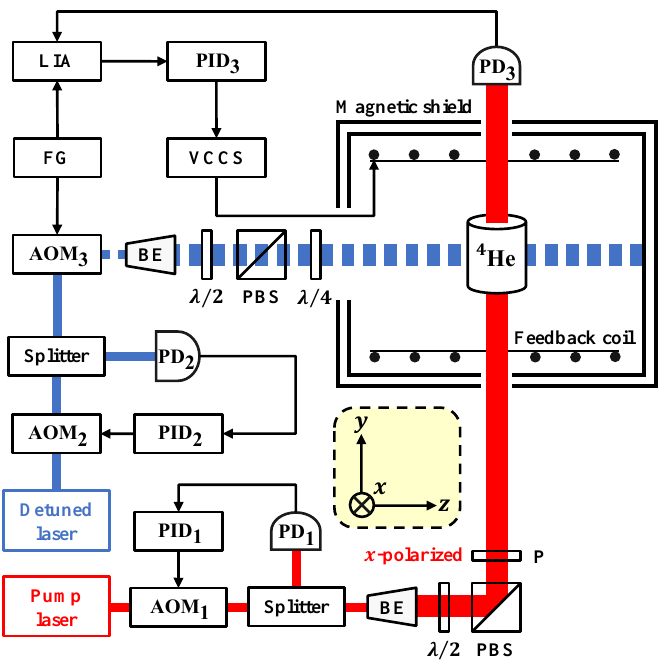
Figure 2. Schematic diagram of the optically modulated alignment-based 4 He parametric-resonance magnetometer operated in the closed-loop mode. AOM, acousto-optic modulator; PD, photodiode; BE, beam expander; PBS, polarization beam splitter; P, polarizer; λ /2, half-wave plate; λ /4, quarter-wave plate; PID, proportional-integral-derivative controller; FG, function generator; LIA, lock-in amplifier; VCCS, voltage-controlled current source. In the open-loop mode, the feedback coil, VCCS, and PID 3 are removed. The intensity of the pump beam is 0.5 mW, and the mean intensity of the sinusoidally modulated light-shift beam is 10 mW. The pump beam and light-shift beam propagate along the longitudinal and orthogonal axes of the cylindrical gas cell placed in a seven-layer µ -metal magnetic shield. The 50-mm-diameter, 70-mm-long gas cell filled with 76 Pa of 4 He pressure is excited by an electrodeless discharge at 39.6 MHz frequency